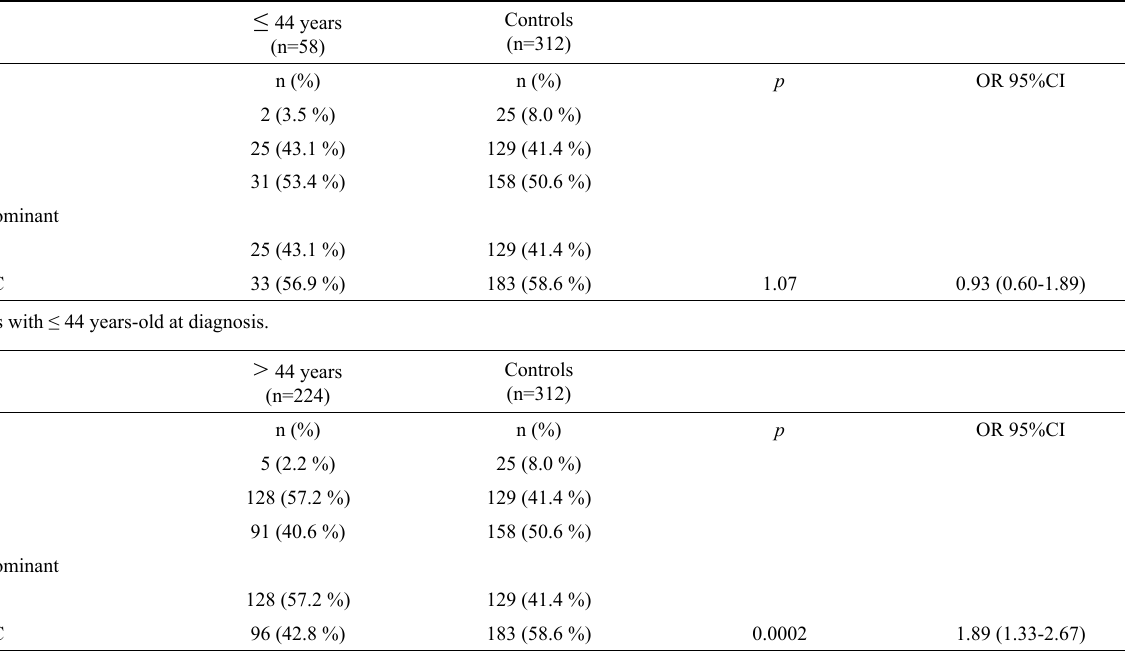
Table 3 – Distribution of patients with genotypes CG and GG + CC in overdominant model based on age of